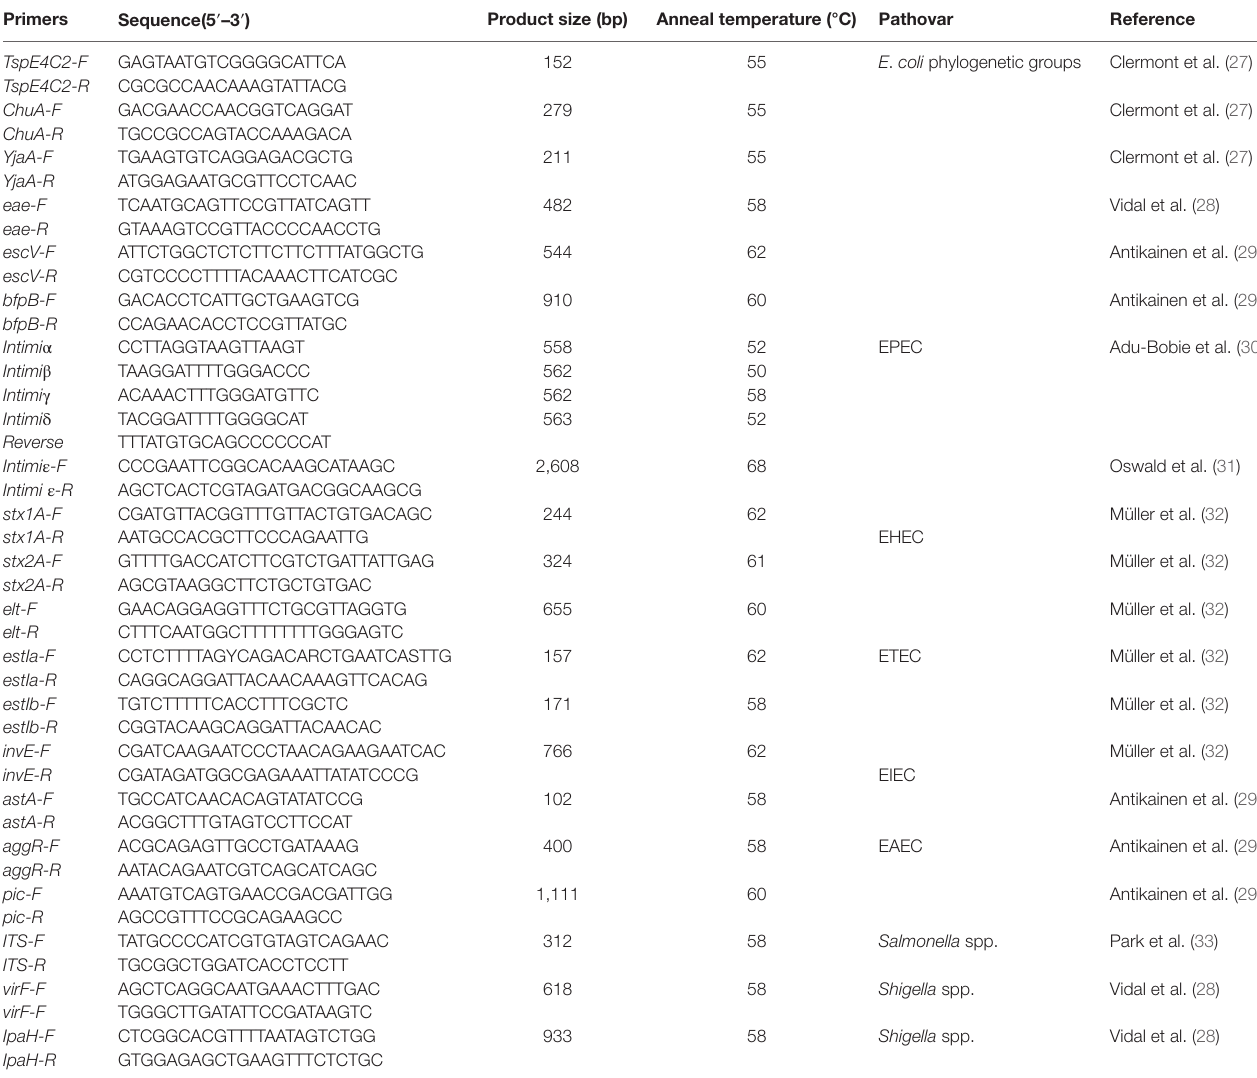
TaBle 2 | Primer sequences, annealing temperatures, and sizes of amplified fragments from selected genes of the target pathogens.